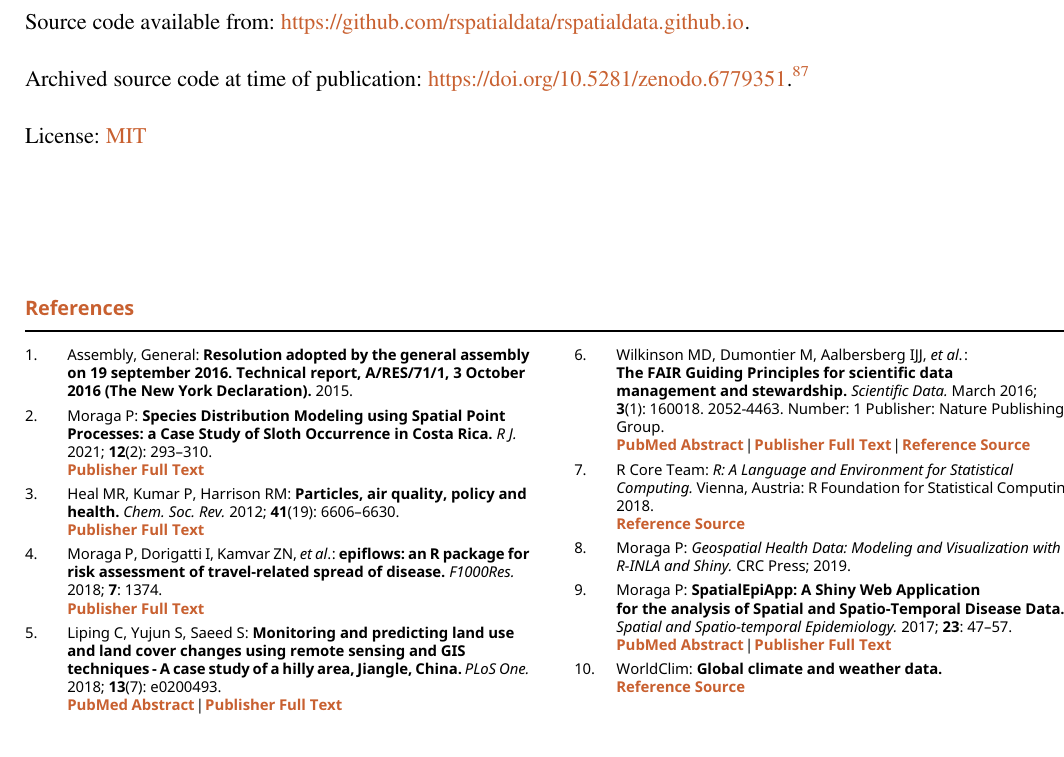
Table 2 contains the databases included in the rspatialdata website.